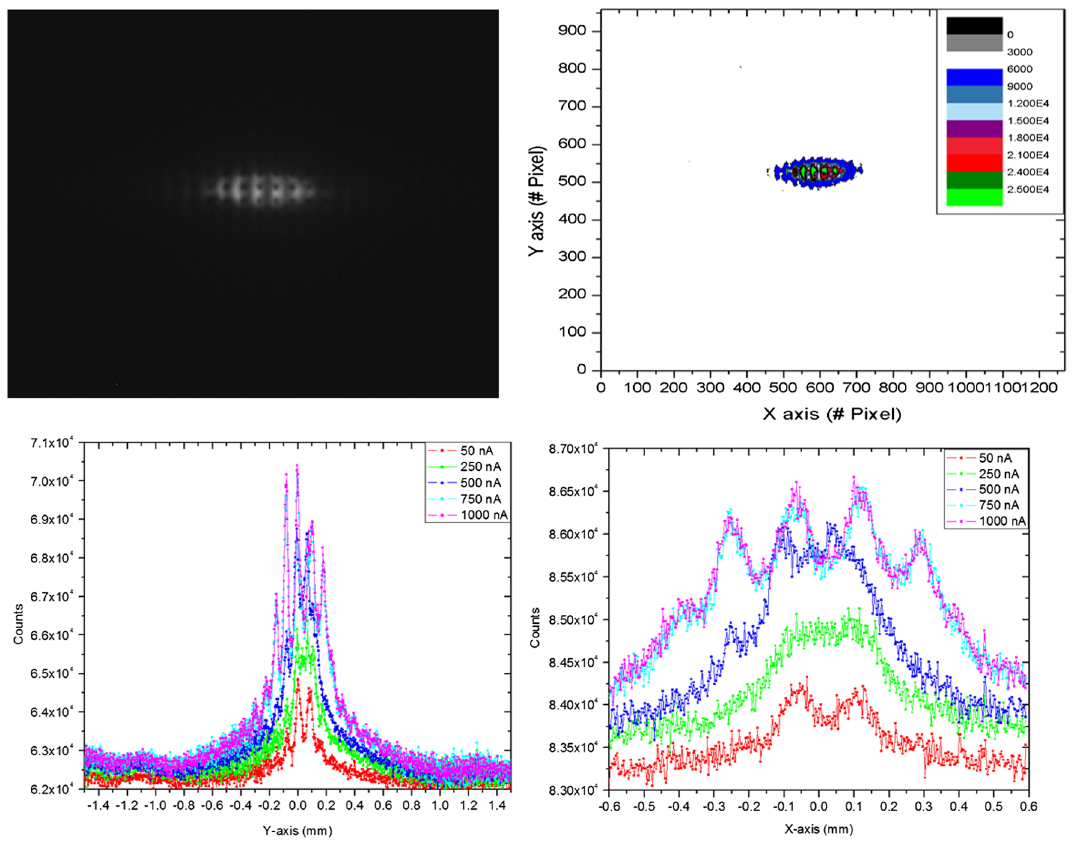
FIG. 11. Beam profile along the transverse axis for various beam currents and with the optimum cooling condition mentioned above: The image represents the transverse beam profile obtained via a CCD camera (top left); contour plot of the transverse beam profile obtained by an RGB analysis method (top right); projection of the image intensity according to the transverse axis for various beam currents (bottom).